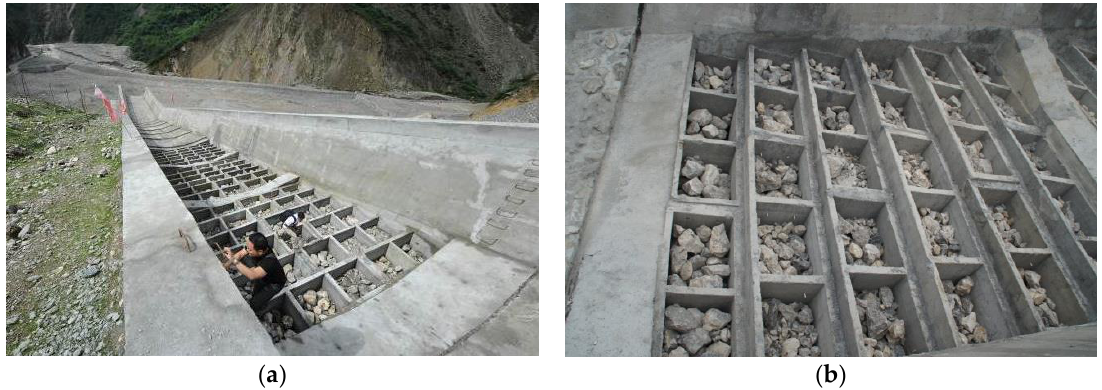
Figure 7. Pictures of energy dissipation (ED) section lined with prefabricated reinforced concrete (PRC) boxes completed. ( a ): From an upstream perspective of ED section, ( b ) Structural details of PRC